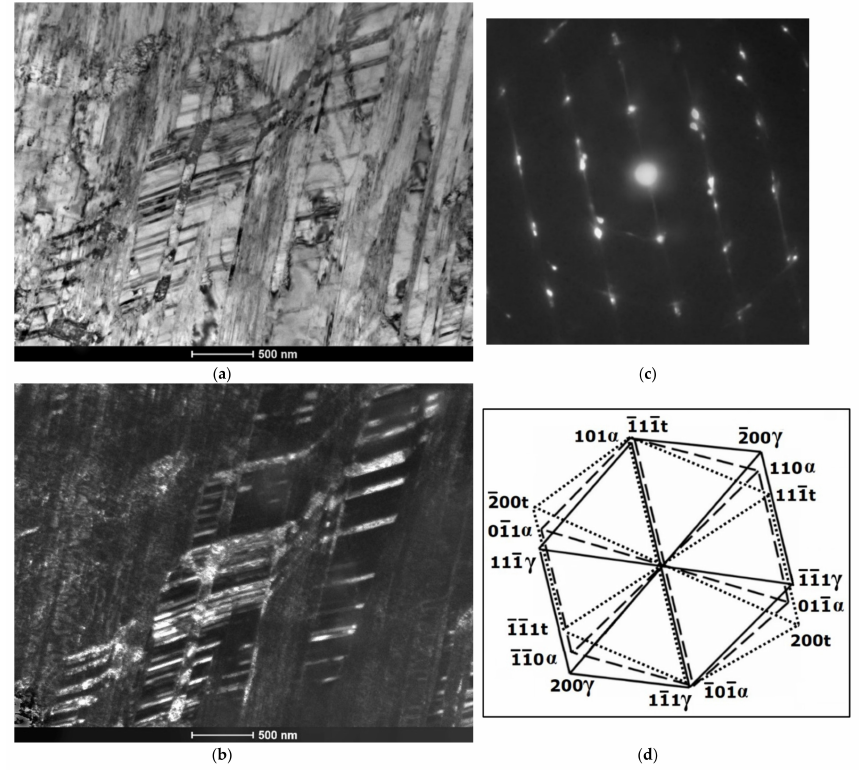
Figure 14. Bright field image of the microstructure after 30% of deformation ( a ), dark field analysis indicating at the formation of strain induced α ’-martensite within deformation bands ( b ) and SAED pattern with schematic representation ( c , d